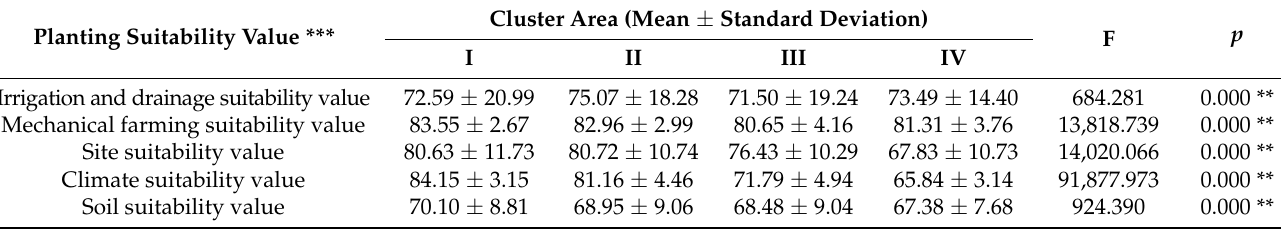
Table 4. Variance analysis results.